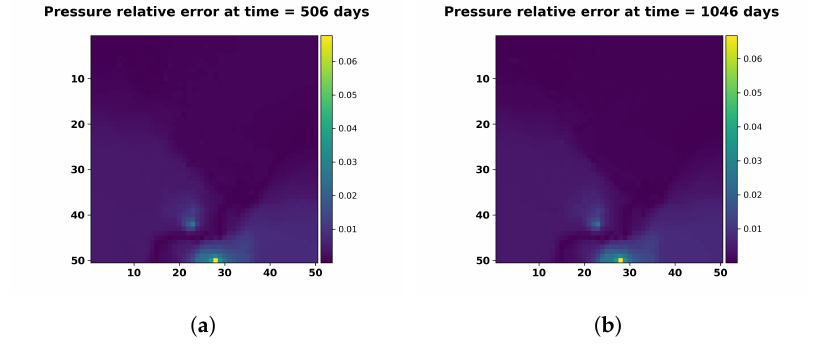
Figure 36. Relative error in pressure at time = ( a ) 506 days ( b ) 1046